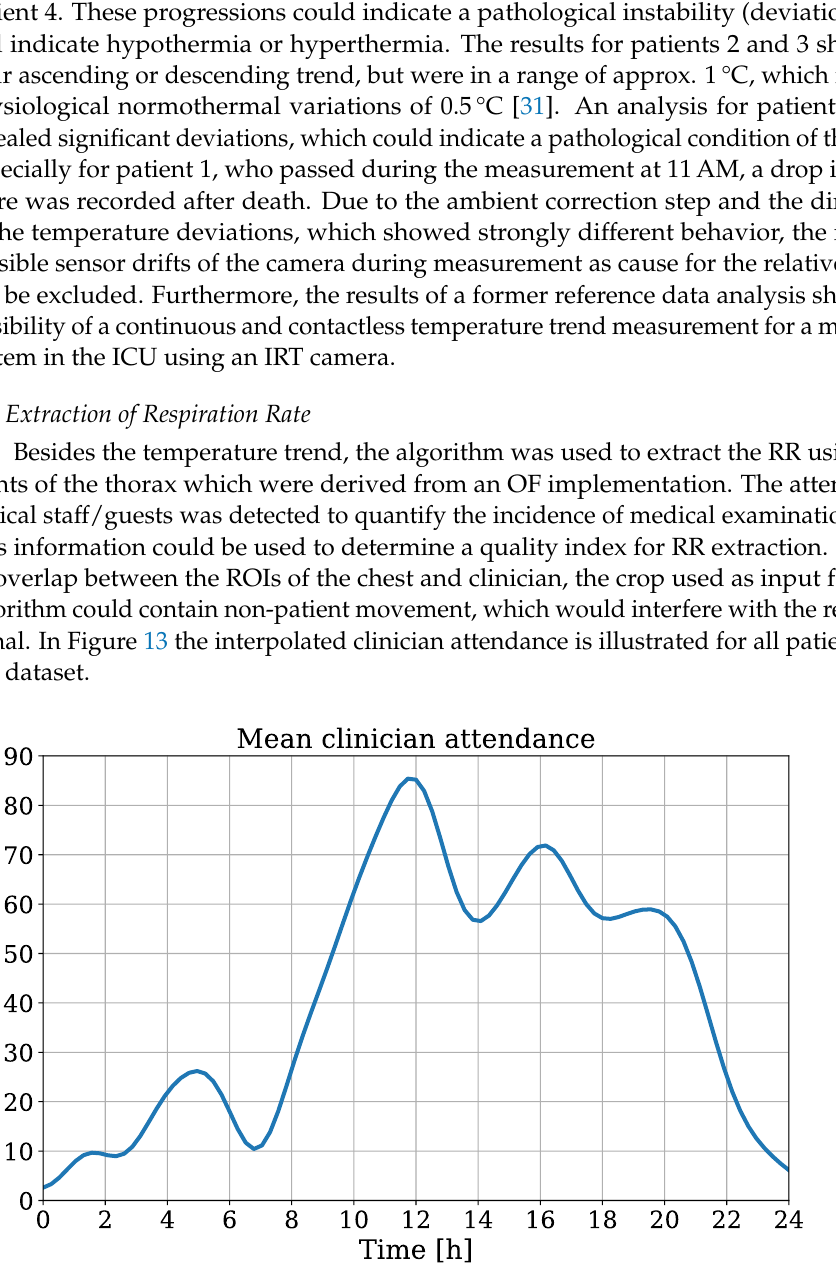
Figure 13. Interpolated clinician attendance from all patients of the test